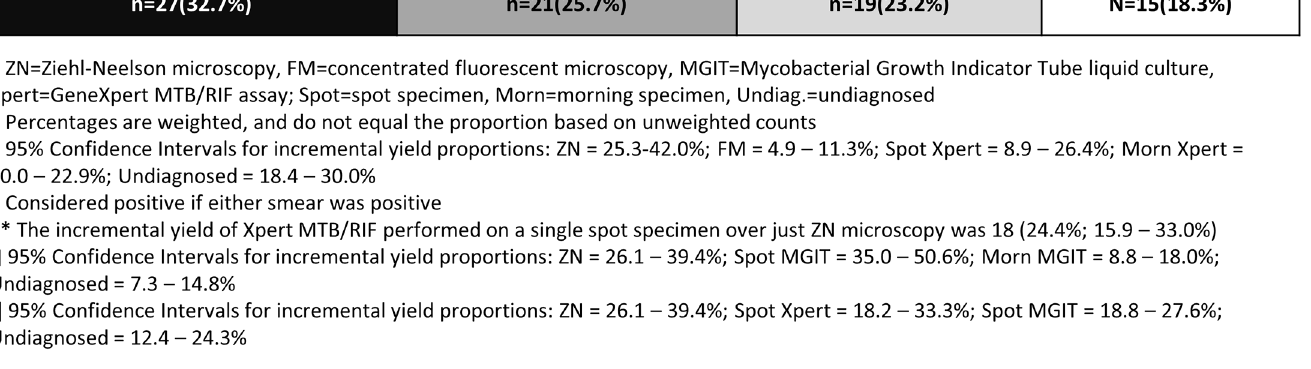
Fig 2. Incremental Yield of Different Diagnostic